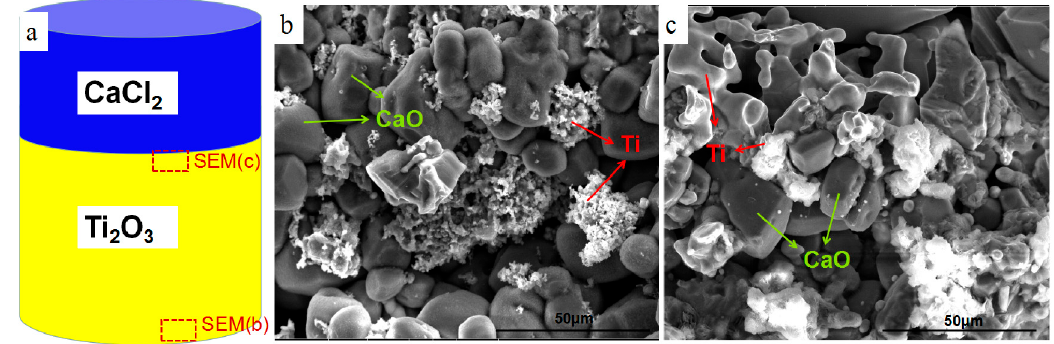
Figure 9. ( a ) Schematic diagram of raw materials; ( b , c ) SEM images of reduction products.